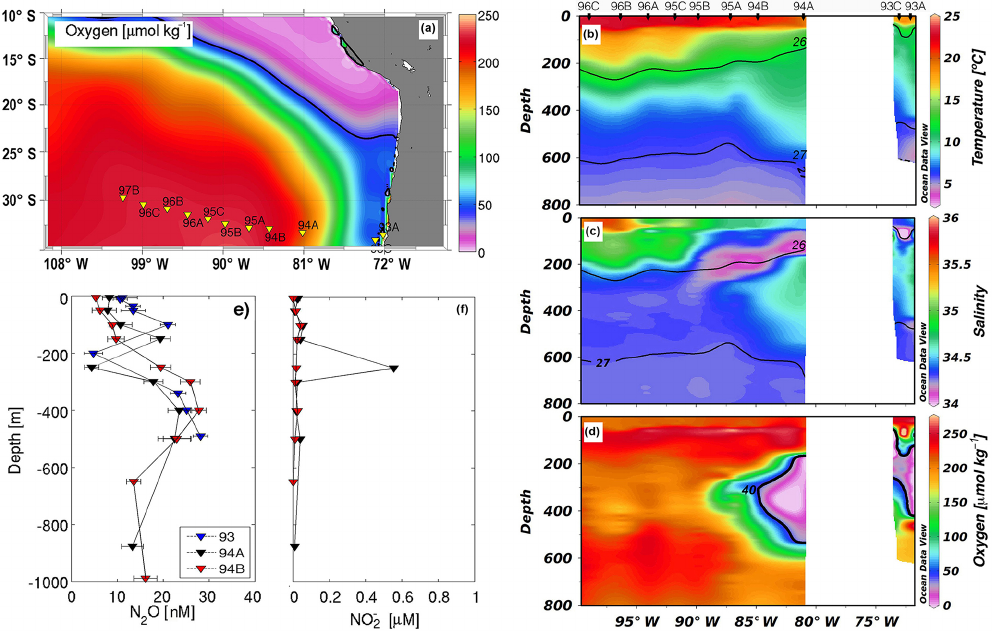
Figure 1. (a) Climatology of dissolved oxygen distributions (µmolkg − 1 ) at a depth of 200m in the eastern South Pacific Ocean. Yel- low triangles indicate locations of stations during the Tara Oceans cruise. Vertical distributions of (b) temperature ( ◦ C), (c) salinity and (d) dissolved oxygen along the transect of the Tara Ocean cruise, from coastal water off Chile to the open ocean. Black lines in (b) and (c) indicate the 26.0 and 27.0kgm − 3 σ t isopycnals. Black line in (d) indicates the isoclines of 40µmolkg − 1 of dissolved oxy- gen. (e) Vertical distribution of N 2 O at Tara stations 093 (34.0 ◦ S / 73.0 ◦ W, blue triangles; TARA_20110312T1637Z_093_EVENT_CAST), 094-A (33.2 ◦ S / 81.1 ◦ W, black triangles; TARA_20110316T1152Z_999_EVENT_CAST) and 094-B (32.8 ◦ S / 84.8 ◦ W, red triangles; TARA_20110317T1815Z_999_EVENT_CAST). (f) Vertical distribution of NO − at Tara stations, 094-A (black triangles) and 094-B (red 2 triangles). For a complete detail of the Tara CTD cast please refer to (Picheral et al.,